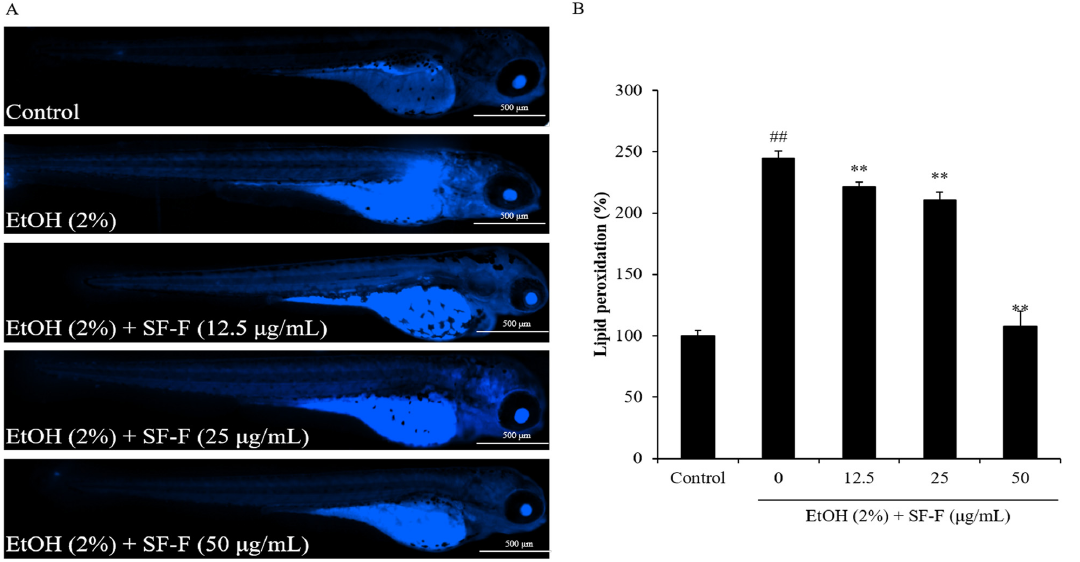
Figure 5. The protective effect of SF-F during EtOH-induced cell death in zebrafish. ( A ) Zebrafish under fluorescence microscope; ( B ) the measured levels of cell death. Cell death was detected by AO staining and cell death levels of EtOH-treated zebrafish were measured by ImageJ software. The experiments were conducted in triplicate, and the data are expressed as the mean ± SE ( n = 3). * p < 0.05, ** p < 0.01 as compared to the EtOH-treated group and ## p < 0.01 as compared to the control group. Furthermore, as Figure 6 shows, the lipid peroxidation level of EtOH-treated zebrafish was increased to 244.74% compared to the control group (100%). However, the lipid peroxidation levels of EtOH-treated zebrafish treated with 12.5, 25, and 50 µ g/mL SF- F were decreased to 221.45, 210.42, and 107.50%, respectively (Figure 6). These results demonstrate that SF-F remarkably inhibited EtOH-stimulated lipid peroxidation in a dose- dependent manner.